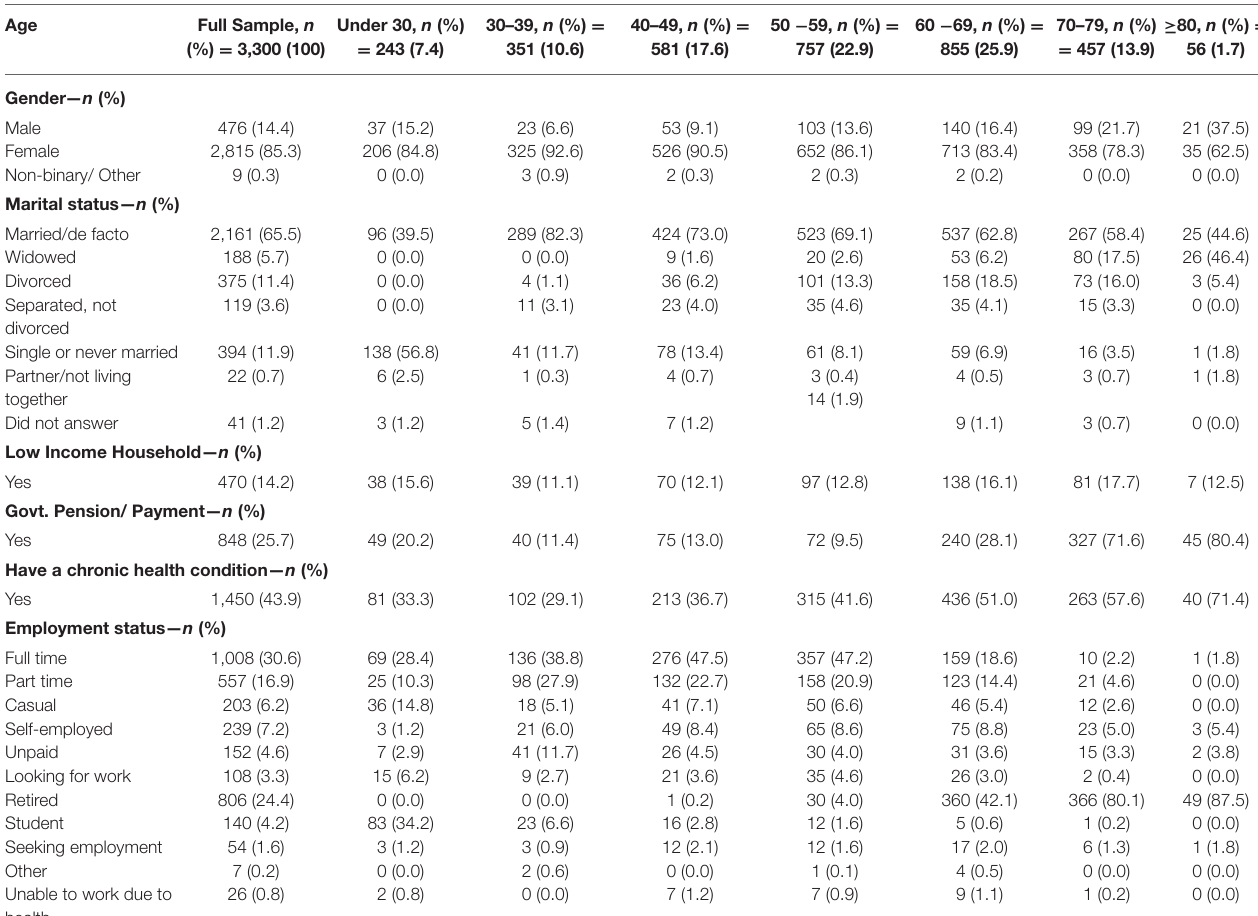
TABLE 1 | Sample demographics across age